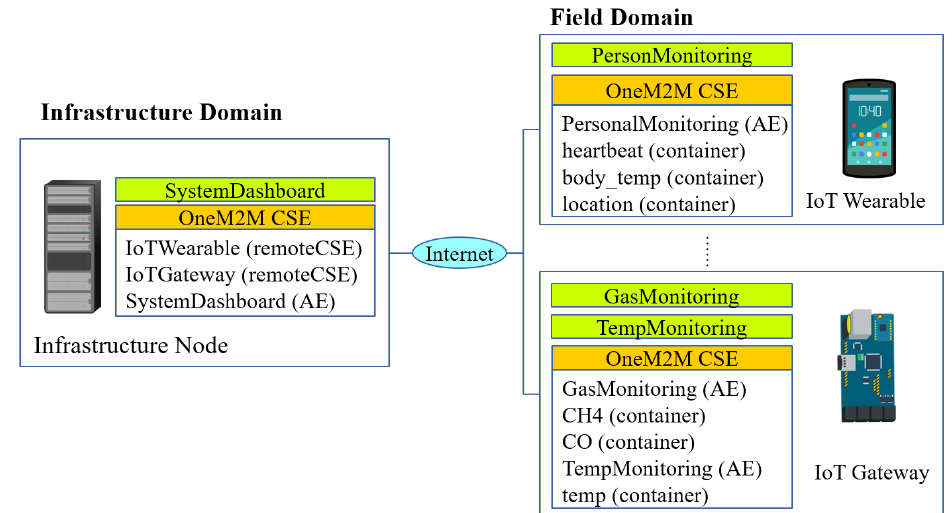
Figure 3. An example of oneM2M-based IoT network.